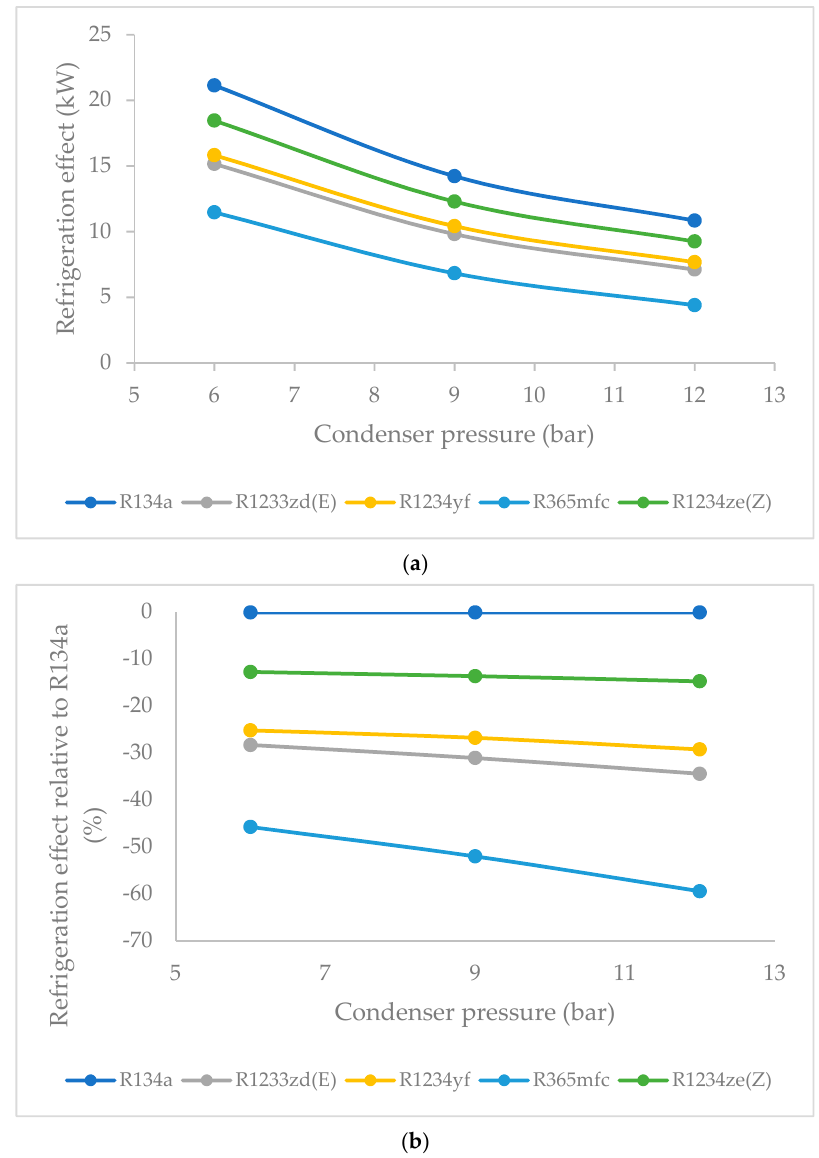
Figure 6. ( a ) Refrigeration effect as a function of condenser pressure (evaporator pressure = 1.5 bar). ( b ) Refrigeration effect relative to R134a (%) (evaporator pressure = 1.5 bar).